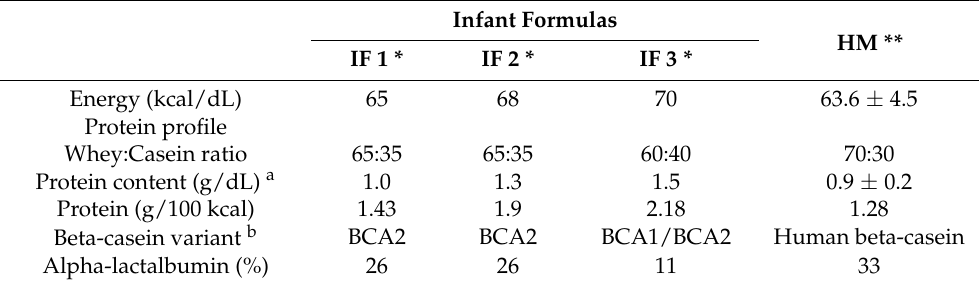
Table 1. Energy and protein profiles of the three study infant formulas and human